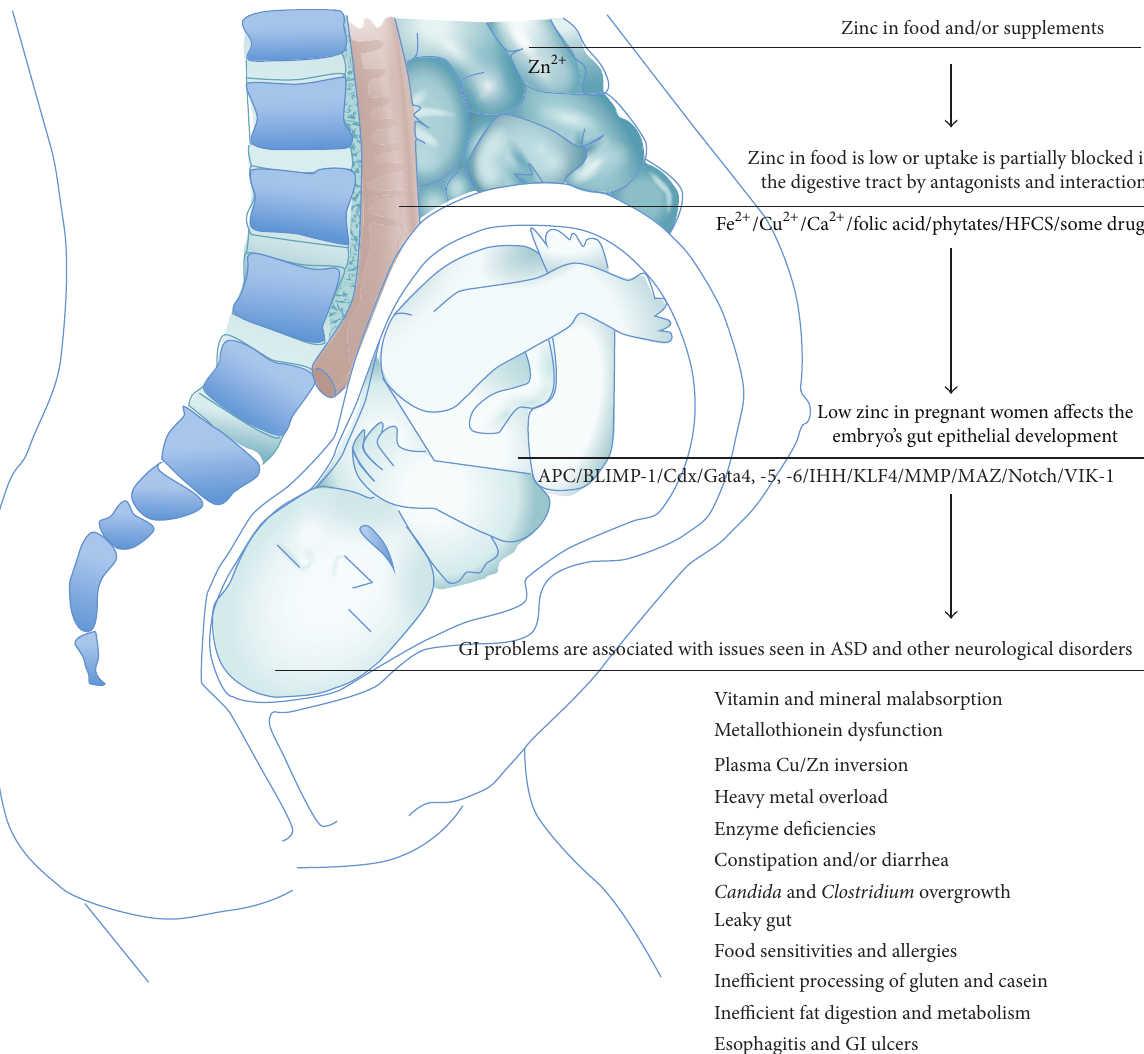
Figure 3: A model for Zinc in gut-brain interaction in ASD and other neurological disorders. Zinc is taken up from our dietary sources and/or supplements in the proximal small intestine. However, absorption of zinc can be decreased in response to various agents such as iron and/or calcium supplements, high copper levels, folic acid, phytate, high fructose corn syrup (HFCS), and/or several drugs. Alternatively, zinc levels may be low due to genetic variants in zinc homeostasis genes or general low availability of zinc in the diet. As a result of this, zinc deficiency of the embryo may occur. Zinc deficiency might influence embryonic and fetal development affecting the GI system through impaired function of several key proteins contributing to many of the reported GI problems associated with ASD such as metallothionein dysfunction, plasma Cu/Zn inversion, heavy metal overload, Candida and Clostridium overgrowth, constipation and/or diarrhea, leaky gut, food sensitivities and allergies, inefficient processing of gluten and casein, enzyme deficiency, vitamin and mineral malabsorption, inefficient fat digestion and metabolism, and esophagitis and GI ulcers. These GI symptoms can give rise to behavioral